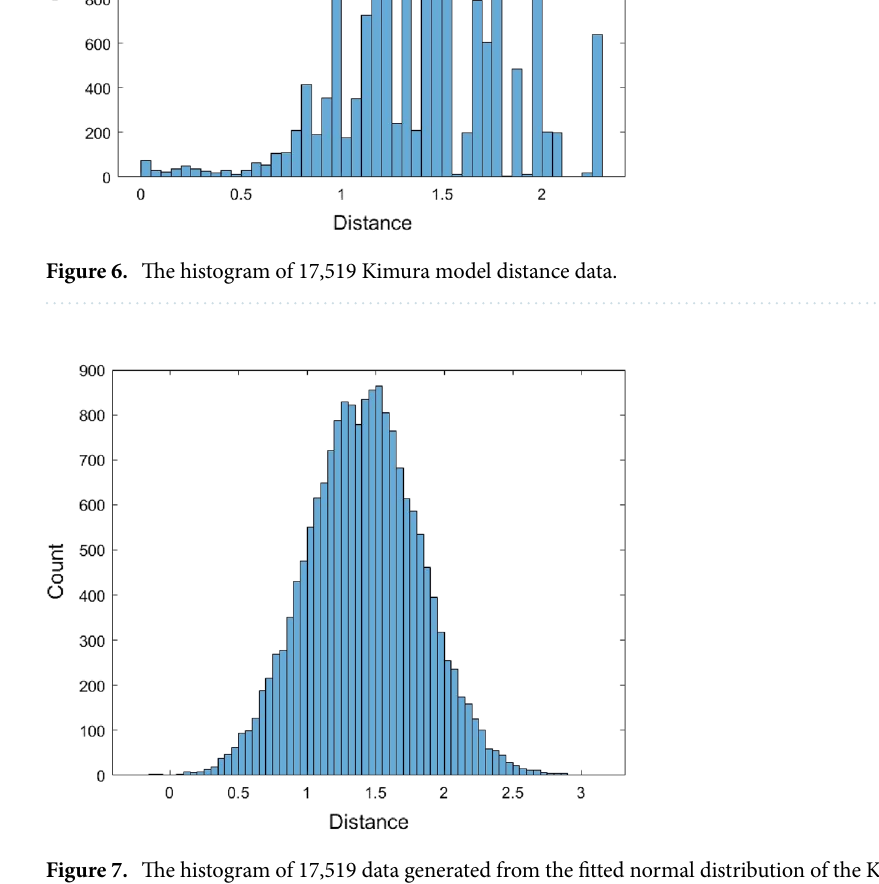
Figure 7. The histogram of 17,519 data generated from the fitted normal distribution of the Kimura model distance